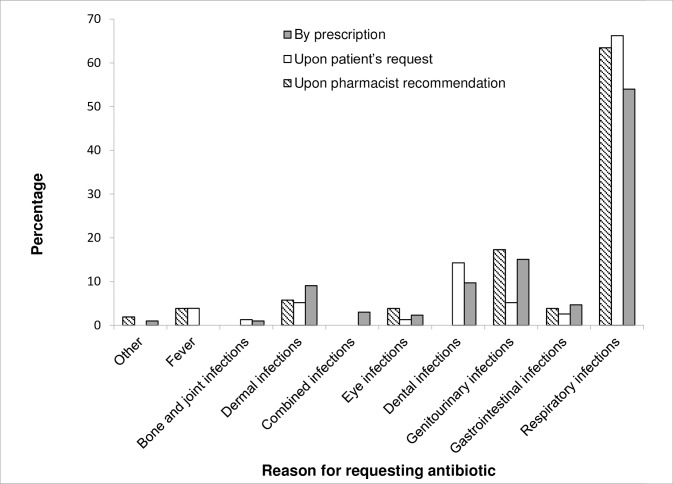
The types of infections to which the patients procured antibiotics, based on prescription, their request, or upon pharmacist's recommendation.